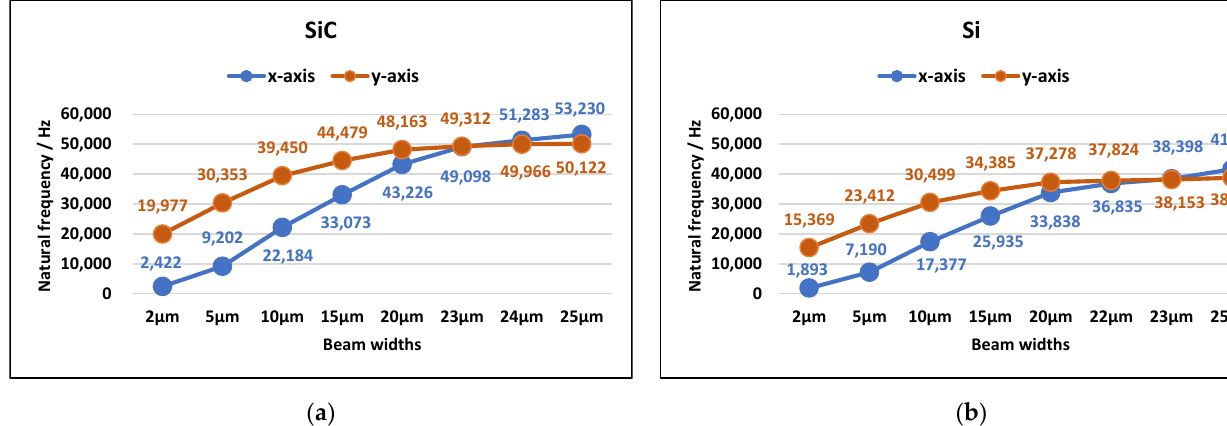
Figure 5. Natural frequencies in the first-two order modes versus the beam width of the capacitive accelerometer based on ( a ) the SiC microstructure and ( b ) the Si microstructure. (The blue line is the natural frequency in the mode moving along the x -axis, while the red line is the natural frequency in the mode moving along the y-axis.)